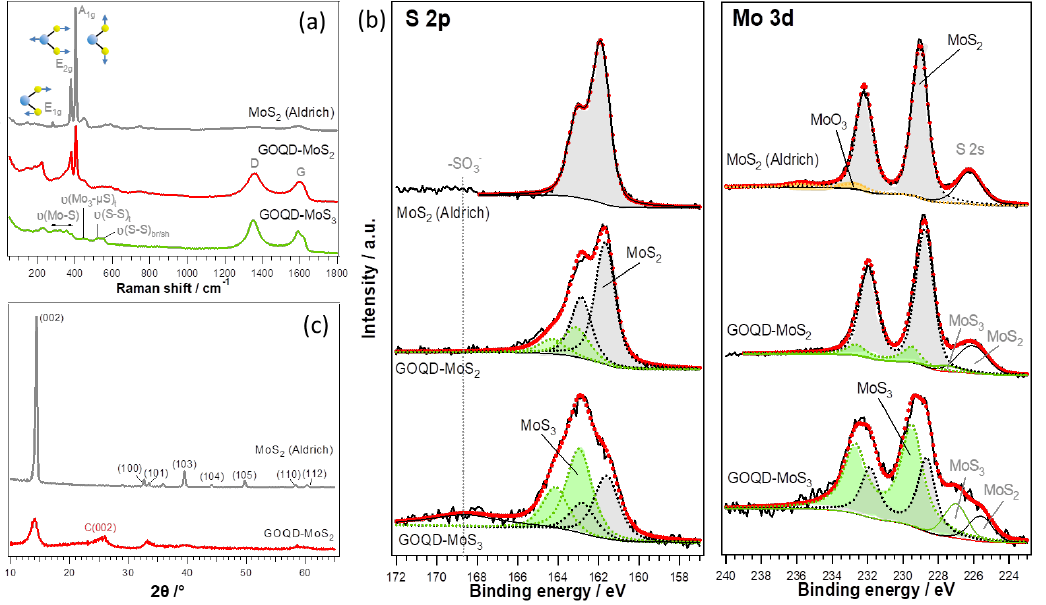
Figure 1. ( a ) Raman spectra; ( b ) S 2 p and Mo 3 d / S 2 s photoemission spectra; and ( c ) XRD patterns for